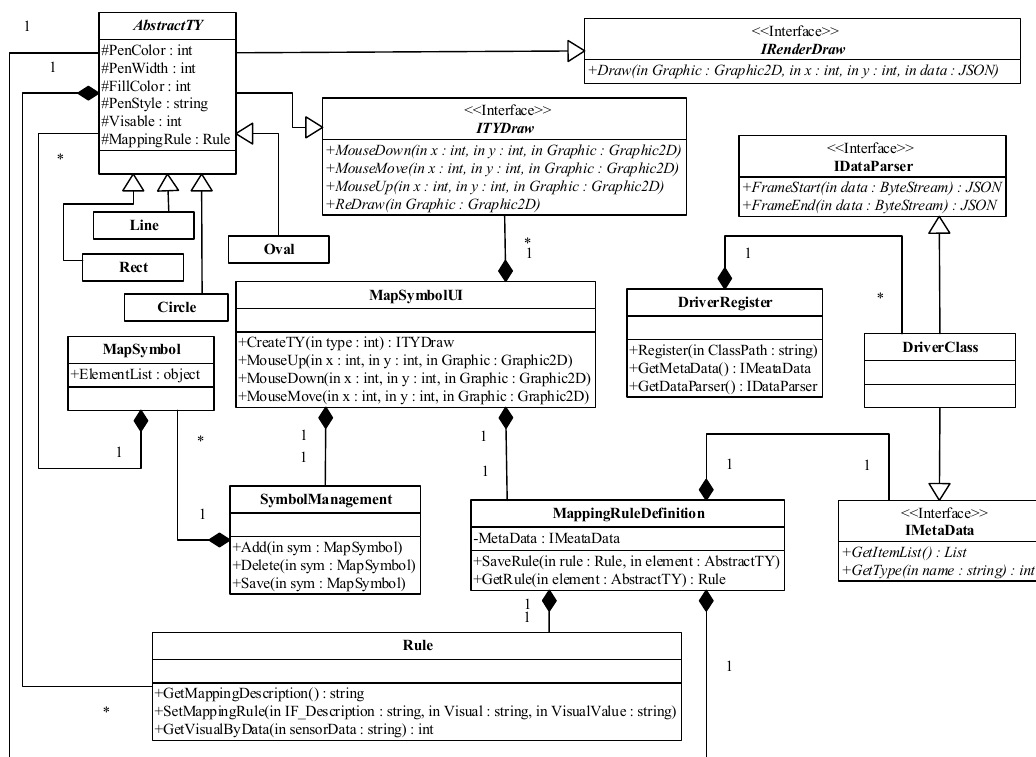
Figure 4. Outline of the protocol-coupling map symbol model.